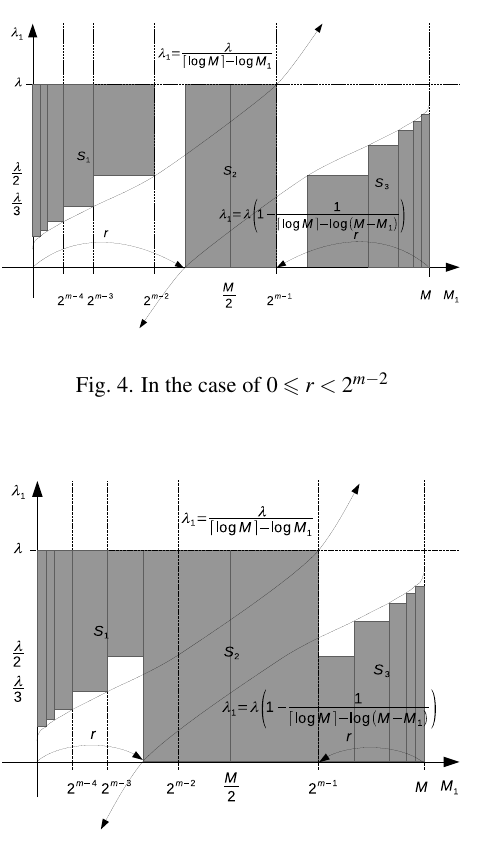
Fig. 5. In the case of 2 m − 2 (cid:54) r < 2 m −